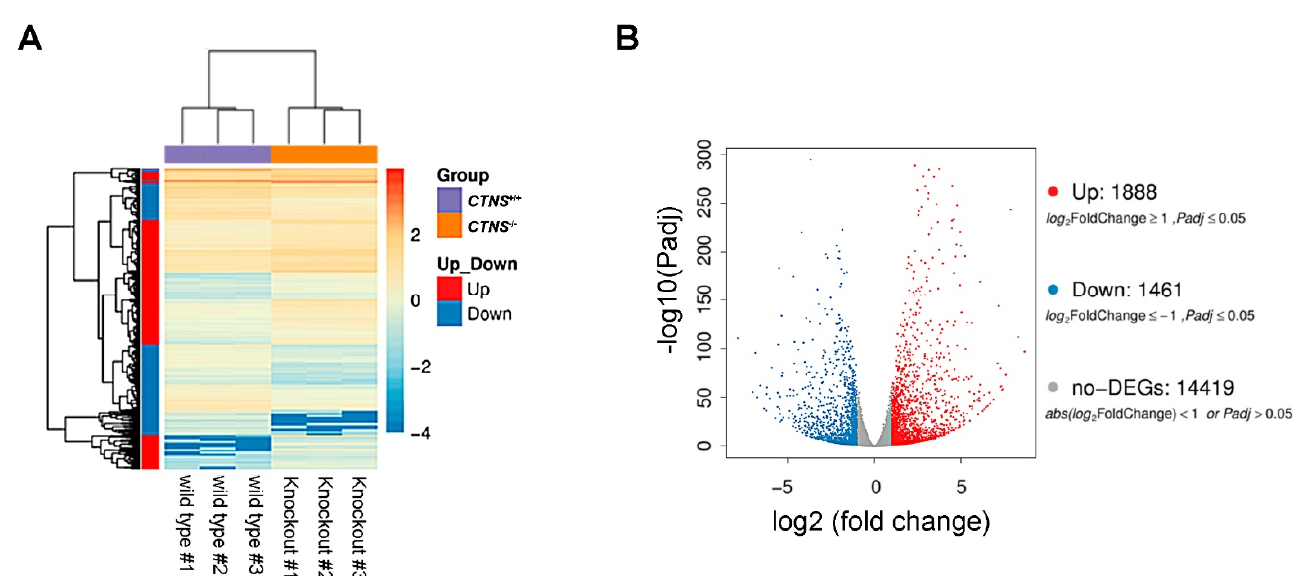
Figure 3. Transcriptome analysis. ( A ) Triplicate of CTNS +/+ (wild-type) and CTNS −/− (knockout) samples are represented on the x axis of the heatmap. DEGs are reported on the y axis and color represents the log10 transformed gene expression level from weak (low expression) to strong (high expression). ( B ) Volcano plot showing DEGs obtained from the RNA-seq dataset with log2 transformed fold change in abscissa and −log10 transformed significance in ordinate (all data in triplicates). Upregulated genes are represented as red points, downregulated genes represented as blue points and no-DEGs represented as gray points.